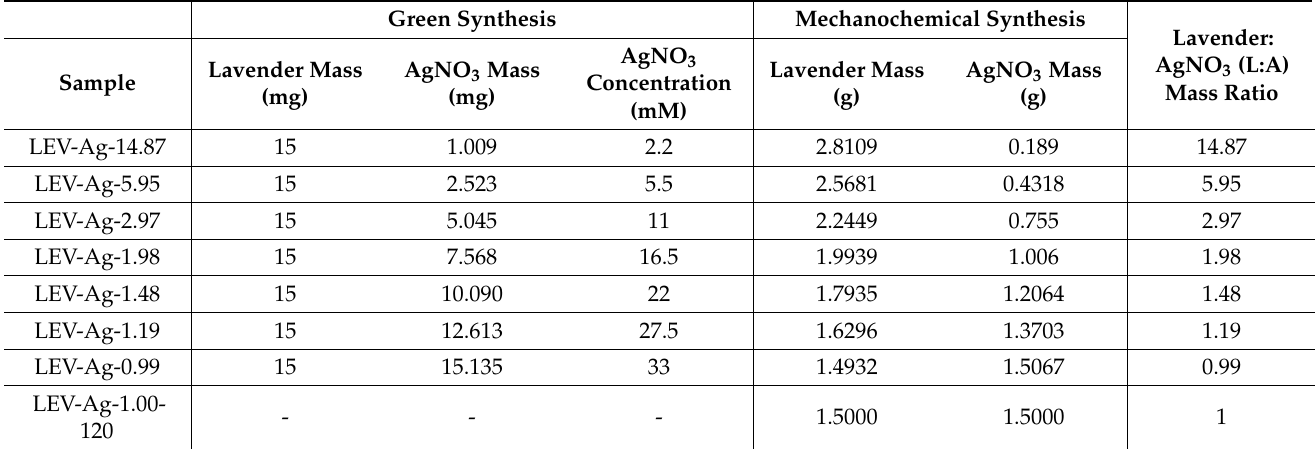
Lavender: AgNO 3 (L:A) Mass RatioSample